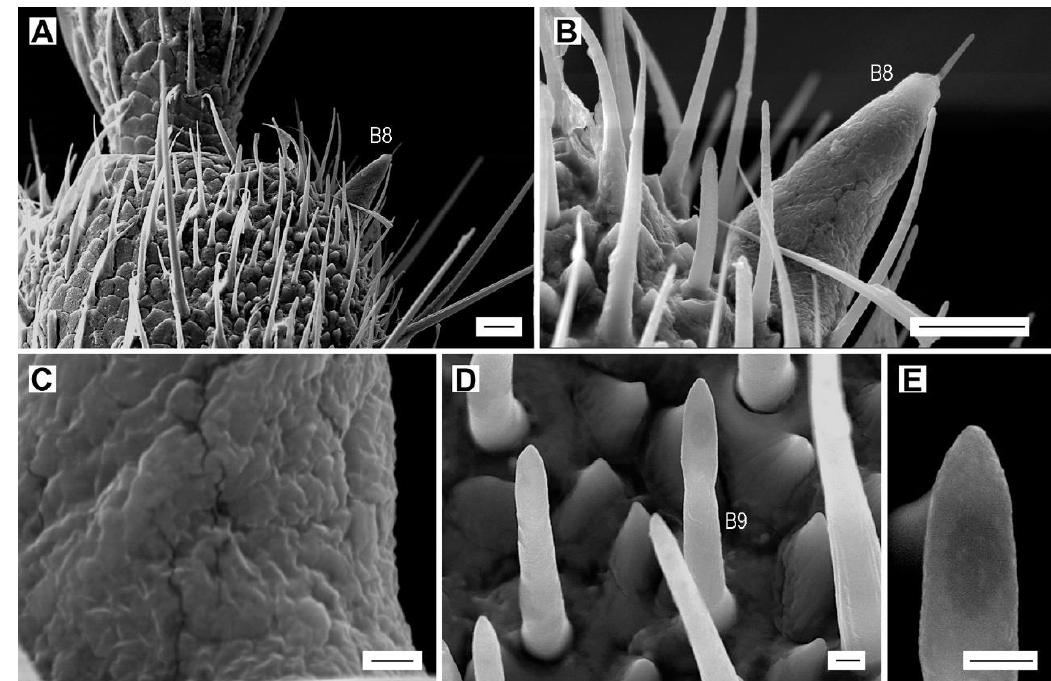
Figure 8. Sensilla basiconica of subtypes B8 and B9. ( A ) A. lineatus , male from Romania, sensillum basiconicum B8 on the distal part of antennomere X; ( B ) sensillum basiconicum B8; ( C ) detail of the wall of sensillum B8; ( D ) A. pilosellus , female, sensillum basiconicum B9 on antennomere VIII; ( E ) detail of the apex of sensillum B9. Scale bars = ( A , B ): 10 μm; ( C–E ): 1 μm.